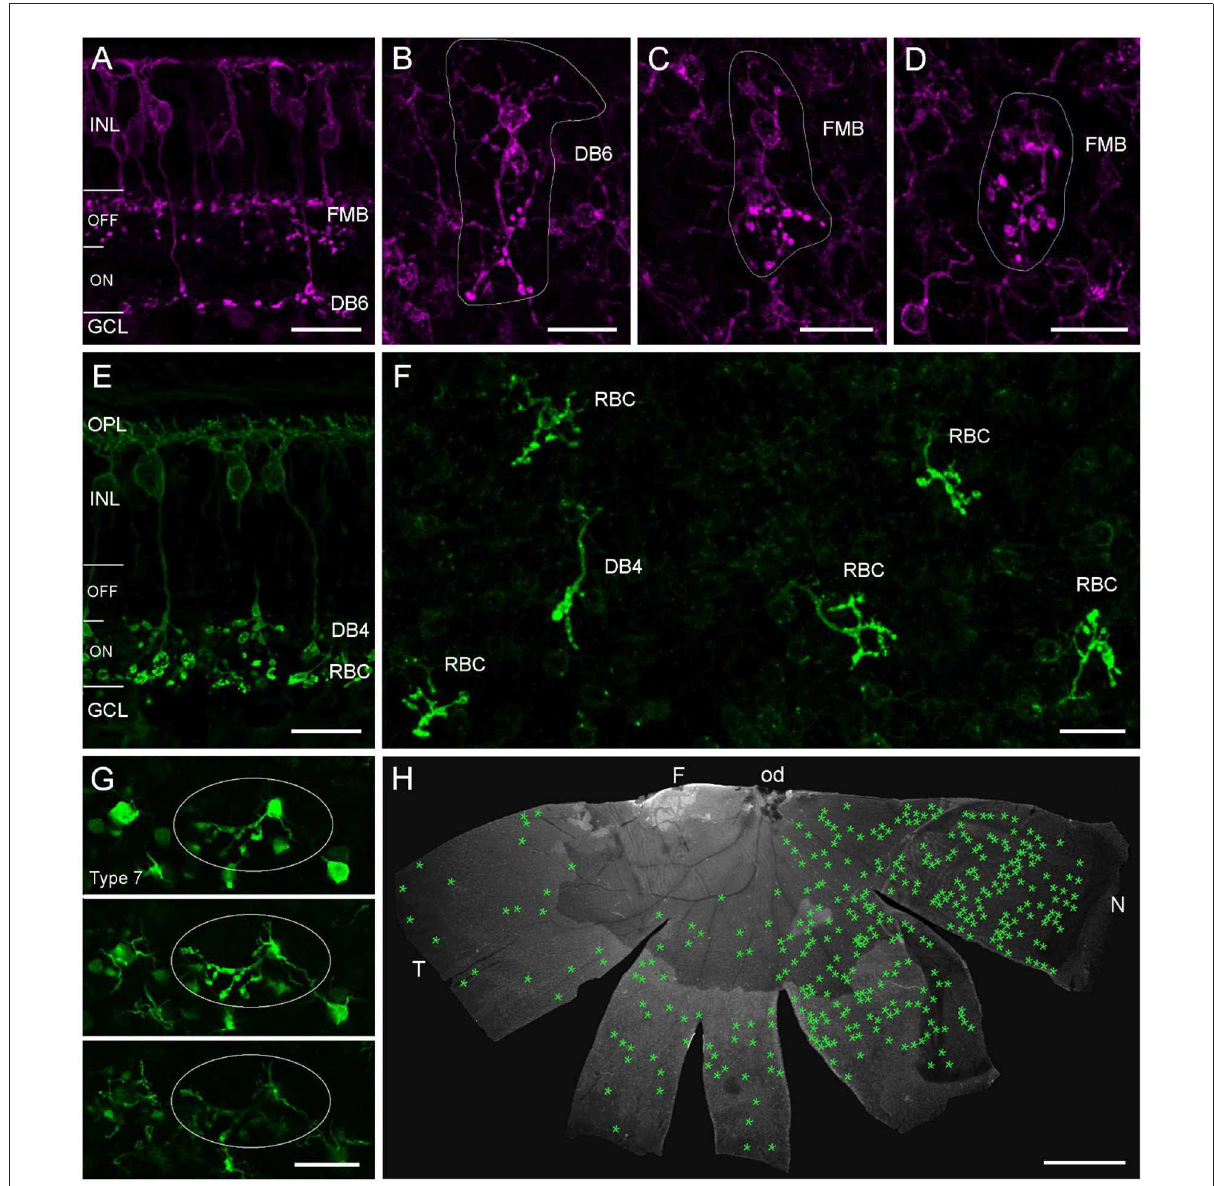
FIGURE6 Misplaced bipolar cell axon terminals in marmoset and mouse retina. Confocal images of marmoset retina (A–F) and mouse retina from a transgenic line (G) immunolabeled for CD15 (A–D) , PKC α (E,F) , or GFP (G) . (A) Vertical vibratome section with two CD15 + BC types. The flat midget bipolar (FMB) stratifies in the OFF layer of the IPL and the DB6 in the deep ON layer. (B) Example of a DB6 cell with its misplaced AT in the OPL in a whole mount preparation of a 2-year-old male. Soma with dendrites and misplaced AT are encircled. (C,D) Examples of two FMBs with misplaced ATs in the same retina as in (B) . (E) Vertical vibratome section with two PKC α -labeled BC types. Both cell types stratify in the ON layer, the DB4 in S3 of the IPL and the RBC in S4/5. (F) Confocal image of several misplaced RBC ATs and one misplaced DB4 AT from the peripheral nasal retina of a 13-year-old male. (G) Three consecutive confocal planes of an image stack with GFP-expressing type 7 mouse BCs at the level of the outer INL and OPL. One BC has a misplaced AT projecting into the OPL (circled), soma and dendrites appear at the same plane in their normal position. (H) Half retina of the 13-year-old marmoset shown in (F) . Green asterisks mark the position of all misplaced ATs ( n = 349) found in this whole mount preparation. INL, inner nuclear layer; GCL, ganglion cell layer; OPL, outer plexiform layer; F, fovea; od, optic disc; T, temporal; N, nasal. Scale bars, 20 µ m in (A–G) , 2mm in (H)